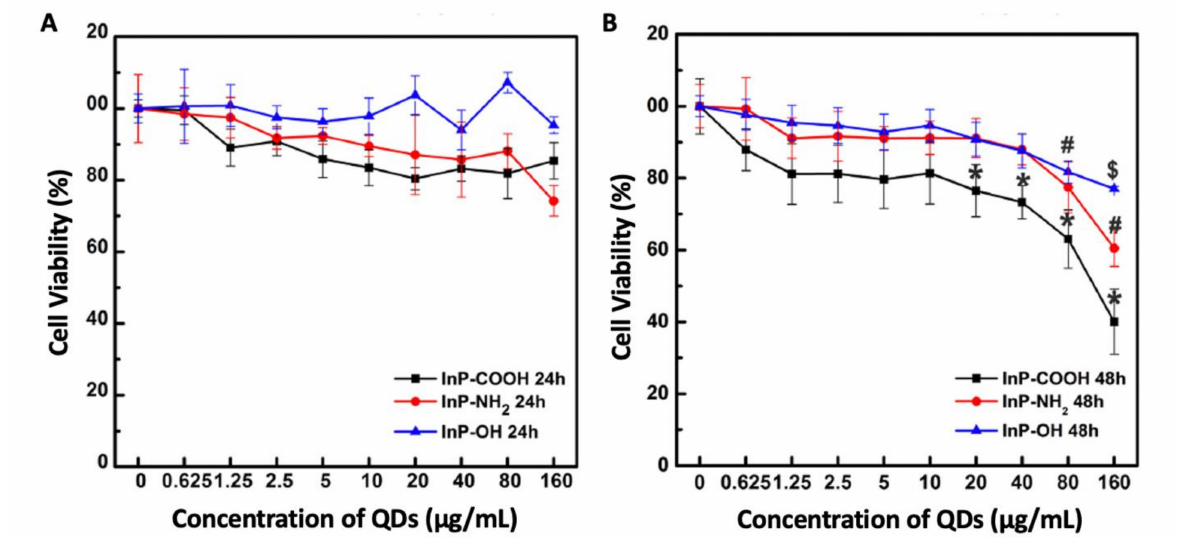
Figure 4. Cell viabilities of RLE-6TN cells after treatment with quantum dots (QDs). Namely, InP/ZnS-COOH, InP/ZnS- NH 2 , and InP/ZnS-OH QDs for 24 ( A ) and 48 h ( B ). Adapted from [69] under the terms of the Creative Commons Attribution License (CC BY); Frontiers Media SA,